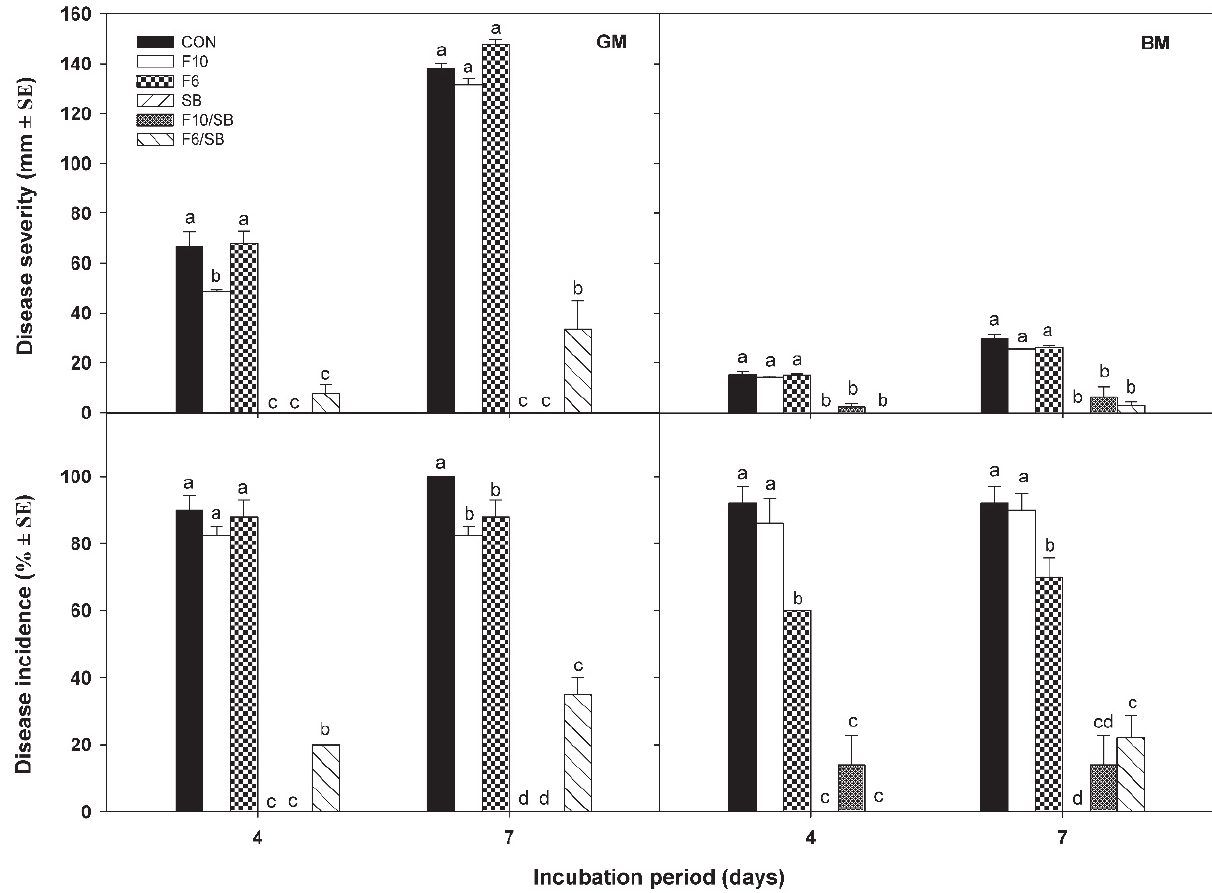
Figure 2. Mean severity and incidence of green mould (GM) or blue mould (BM) on ‘Fino’ lemons artificially inoculated, respectively, with Penicillium digitatum or P. italicum , then coated 24 h later and incubated for 4 and 7 d at 20°C and 90% RH. Treatments applied were: con- trol (CON) = uncoated (immersion in water), F10 coating, F6 coating, 2% sodium benzoate (SB) aqueous solution (w/v), F10/SB coating, or F6/SB coating (see Table 2 for coating composition). For each disease and incubation period, columns accompanied by different letters are significantly different (Fisher’s protected LSD test; P < 0.05). Vertical lines above columns indicate standard errors. Incidence values were arcsine-transformed before statistical analyses. Non-transformed means are